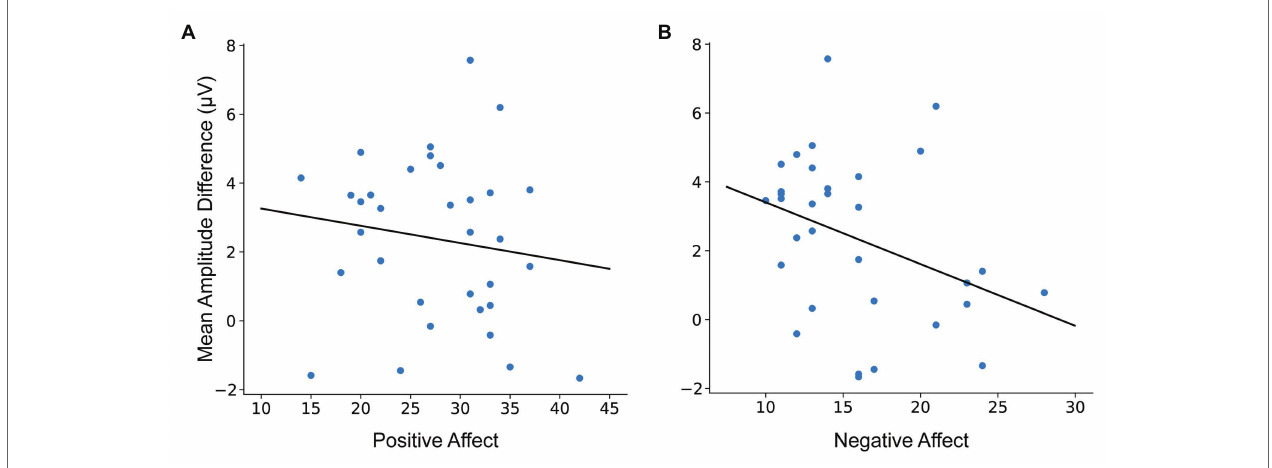
FIGURE 4 | Scatterplot of mean N400 amplitude difference in the definite condition ( the wine – the #roof ) with (A) Positive Affect (PA) and (B) Negative Affect (NA) at the right lateralized centroparietal ROI (Cz, C2, CPz, and